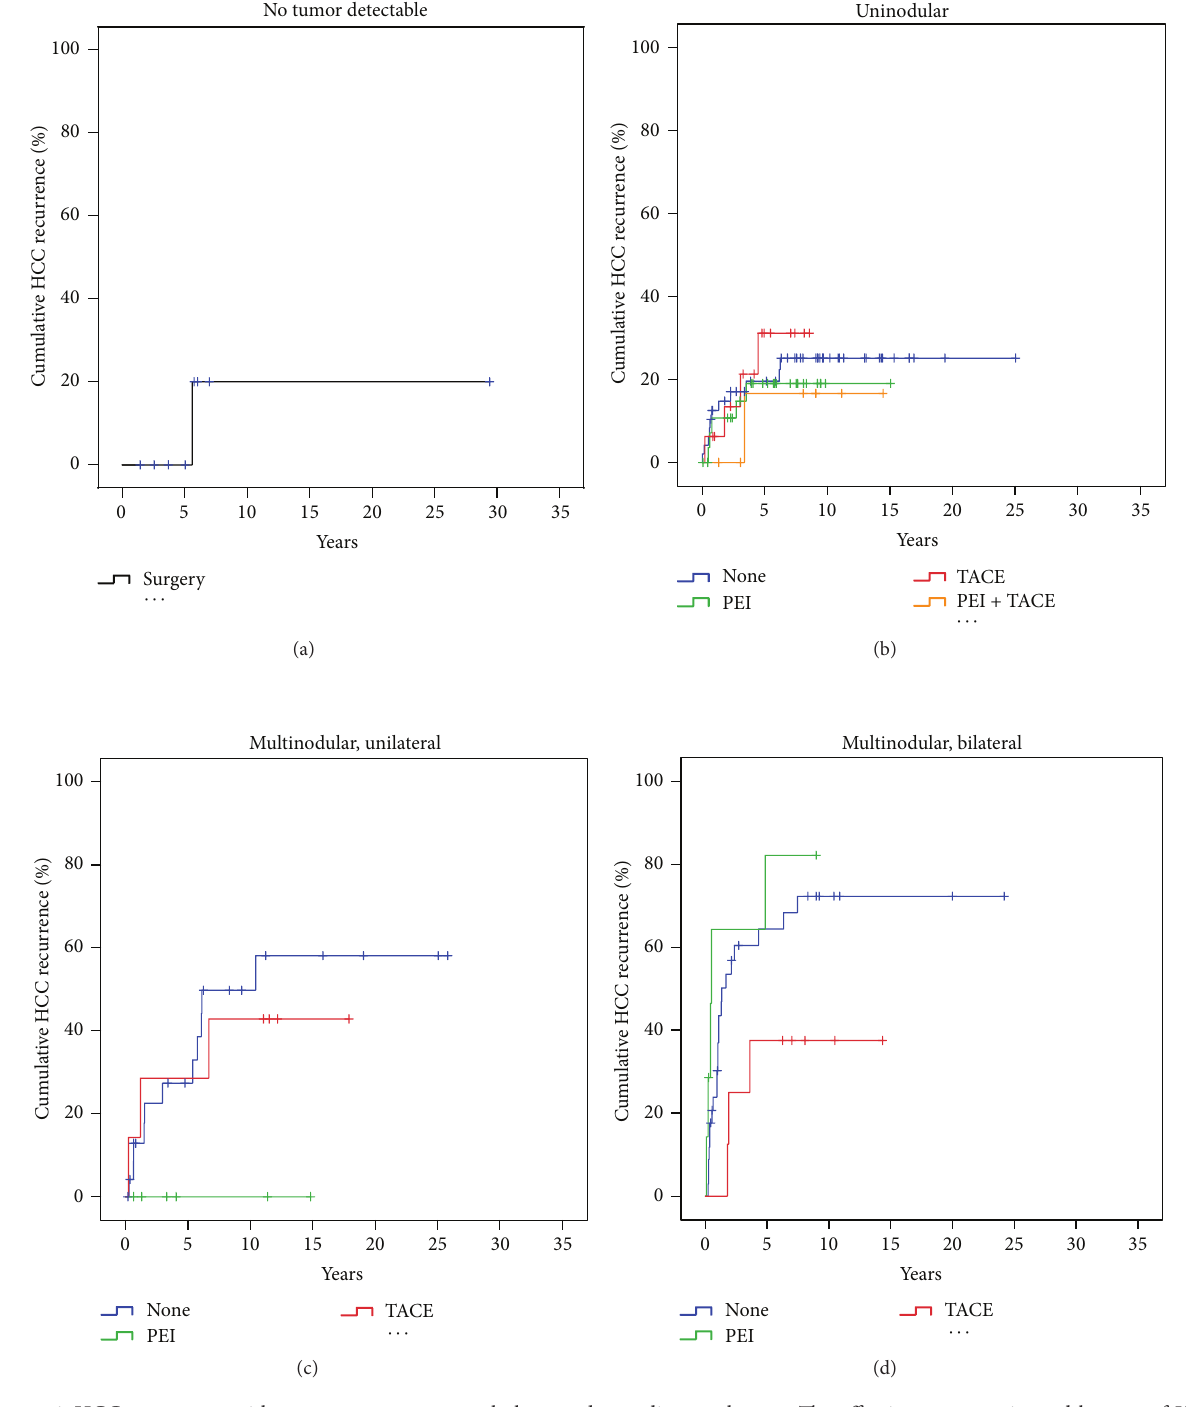
Figure 6: HCC recurrence with respect to tumor morphology and neoadjuvant therapy. The effectiveness as estimated by rate of HCC recurrences was analysed with respect to different neoadjuvant therapy regimen and tumor morphology. Hospital deaths and treatment groups with 𝑛 < 5 were excluded from analysis. Thus, only surgery remained for estimation of cumulative HCC recurrence in the group of nondetectable tumors (a). In the group of uninodular HCC (b) there was no significant difference in HCC recurrence rates comparing the mono- and multimodular pretreatments. Multinodular/unilateral HCC (c) had a significantly lower rate of HCC recurrence (Log Rank 𝑝 < 0.001 )iftreatedby PEI ,while TACE didnotmakeadifferenceforthisgroupoftumorsatall(LogRank 𝑝 > 0.05 ).In multinodular/bilateral tumors (d) TACE was significantly better as compared to PEI (Log Rank 𝑝 < 0.05 ). The PEI group had the same cumulative rate of HCC recurrence as the no-treatment